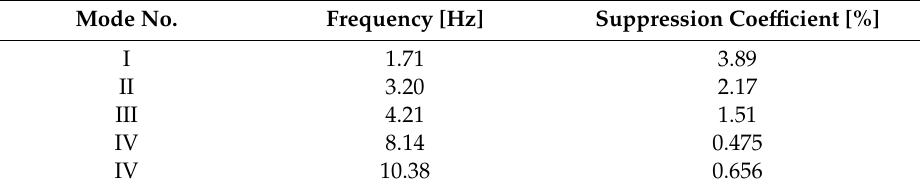
Table 1. Shapes and frequencies of bridge overlay vibrations; values of their suppression coe ffi cients. Mode